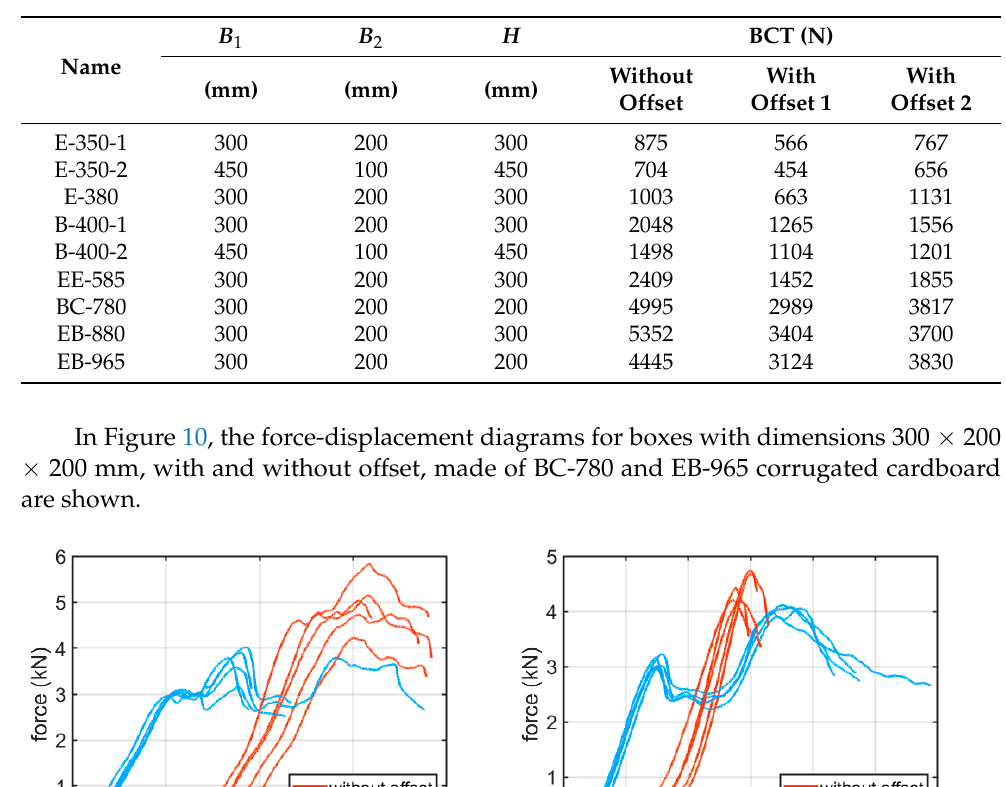
Table 3. Main dimensions and BCT values of various corrugated cardboard packaging.